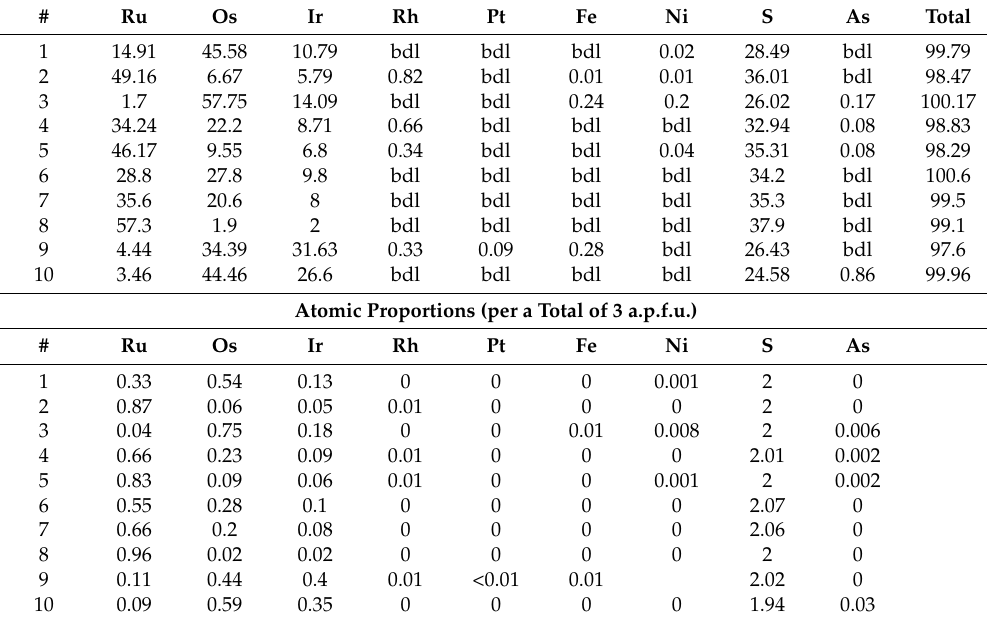
Table 7. Compositions of laurite–erlichmanite inclusions hosted by grains of PGE alloy minerals in the Sisim placer zone, Eastern Sayans.